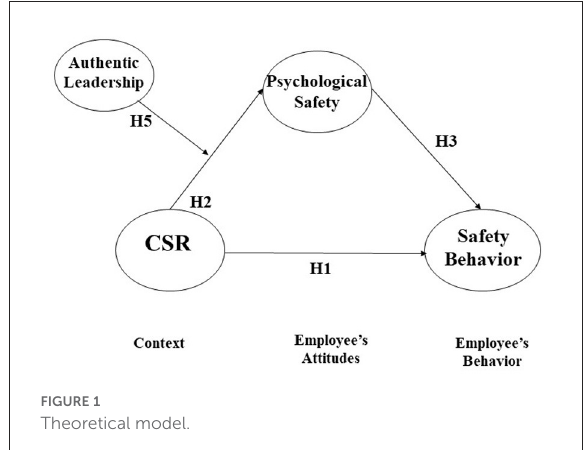
FIGURE1 Theoretical